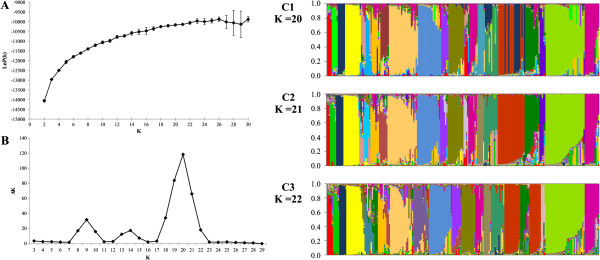
Left panel: Selection of the most likely number of subpopulations (k) for the evaluated accessions. A. Mean values of LnP(K) for 10 independent runs for each k. B. Plot of Δk values for each k based on the second order change of the likelihood function. Right panel C. Graph for ancestralities for k = 20 (C1), k = 21 (C2), and k = 22 (C3). Group colors are function of colors observed for k = 21.